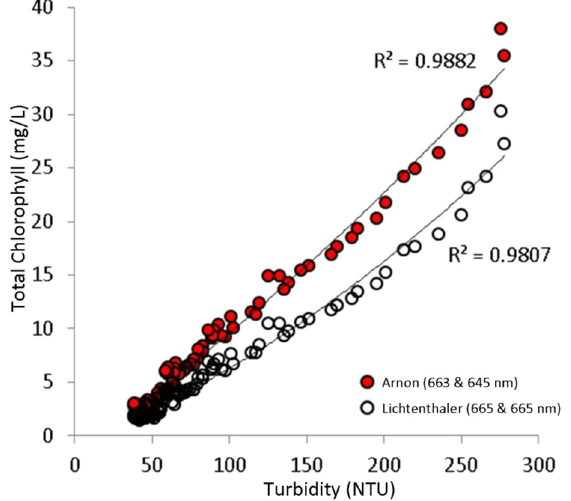
Fig. 7. Relationship between total chlorophyll and B/G index obtained from different